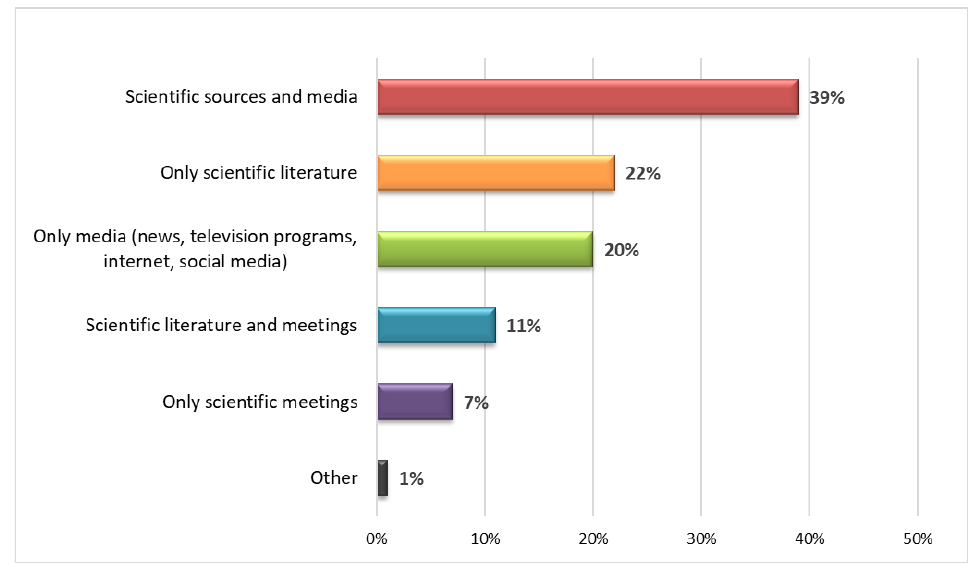
Figure 1. Main sources of information on the COVID-19 pandemic. Table 3. Sources of information about the pandemic and its perception among the